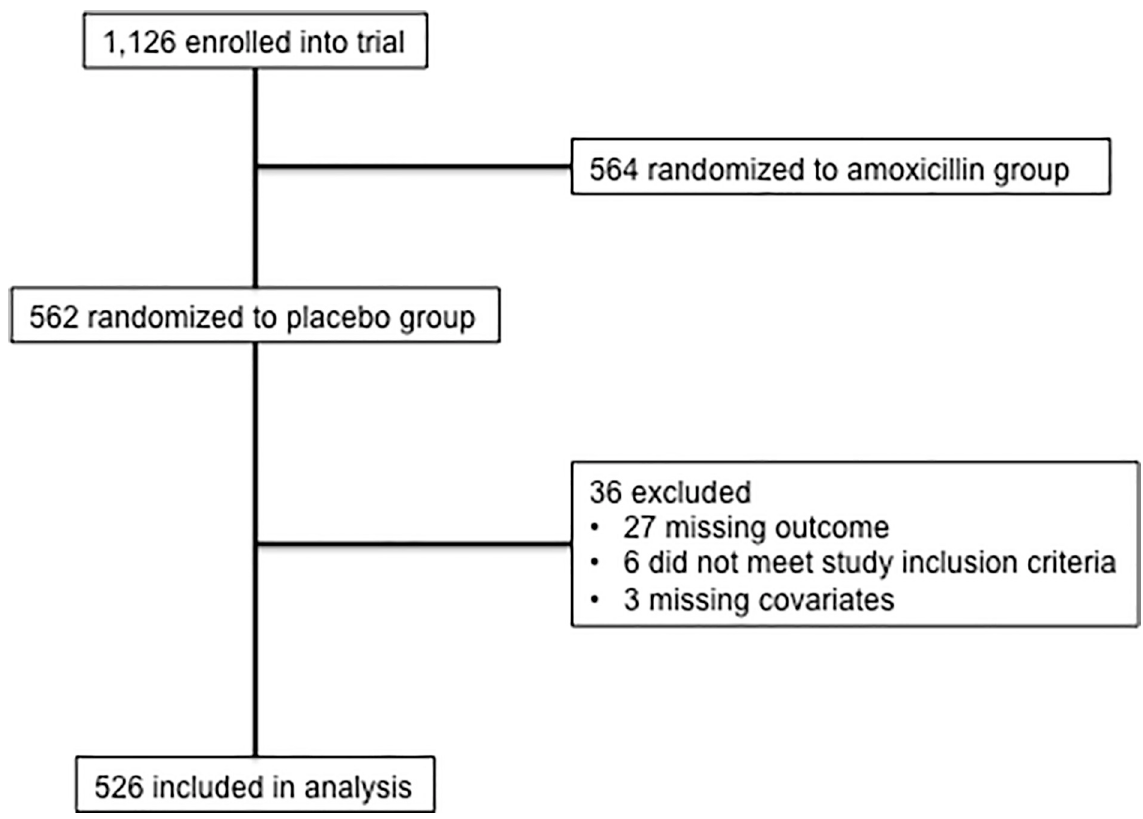
Fig 1. Study schema. respiratory rate (51.7 vs 49.8 breaths/minute, p-value = 0.061), and a difference in categories of water source between children with and without treatment failure or relapse (p-value = 0.083). In Table 4 we report a model that predicts the probability of treatment failure or relapse among children receiving placebo. Heart rate terms, MUAC, malaria status, water source, fam- ily income, and whether or not a sibling or other child in the household received childcare out- side the home were all included in the final predictive model. Specifically, an increase in MUAC, testing malaria positive, the categories of other water source and well water, relative to the piped water referent category, and missing family income were all associated with a lower risk of treatment failure or relapse. On the other hand, increasing family income and having a sibling receive childcare outside the home were associated with a statistically significant higher risk of treatment failure or relapse. Failure rates were the highest for heart rates between 120 and 170, peaking near 145 beats per minute, and reduced for higher or lower baseline heart rates. The model equation is: P failure or relapse